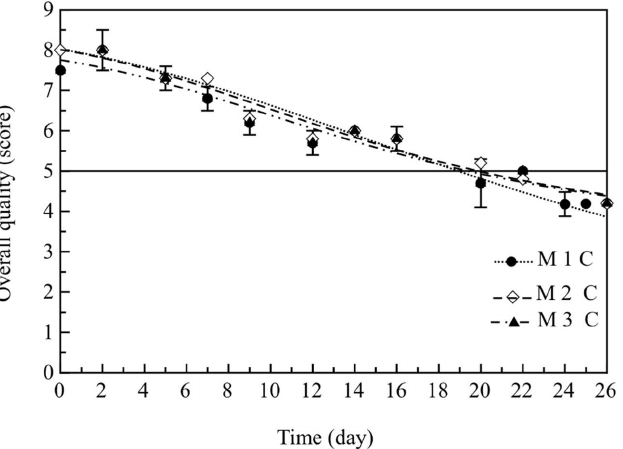
Figure 6. Trend of overall quality of cooked fish burgers during 26 days of storage at 4 °C. Data indicate means ± SD. M1 C: cooked fish burger with mix of juice and re-ground pomegranate by- products; M2 C: cooked fish burger with mix of juice, water and re-ground pomegranate by-products; M3 C: cooked fish burger with mix of juice and ground pomegranate